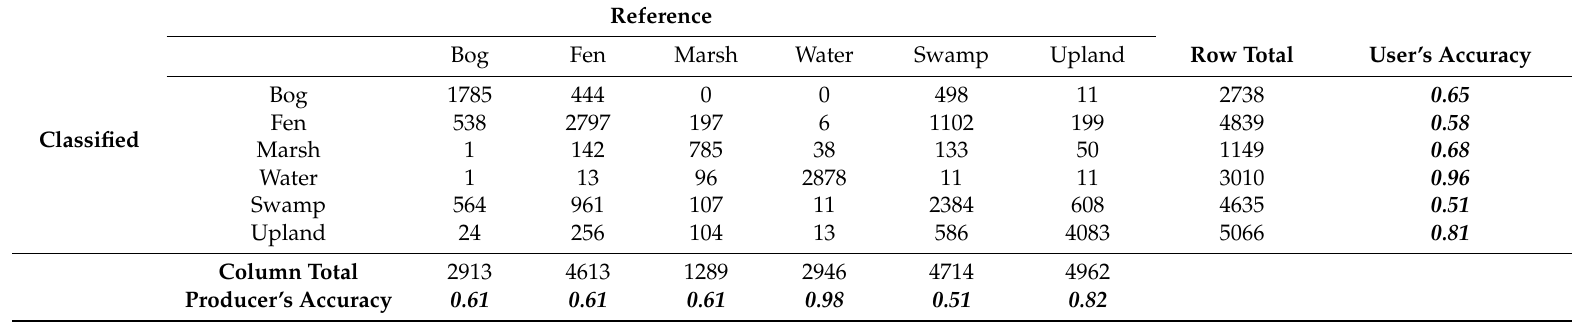
Table 4. Error matrix for the ABMI_PP results including May and October composites for region sampling of photo-plots and hold-out training convergence.